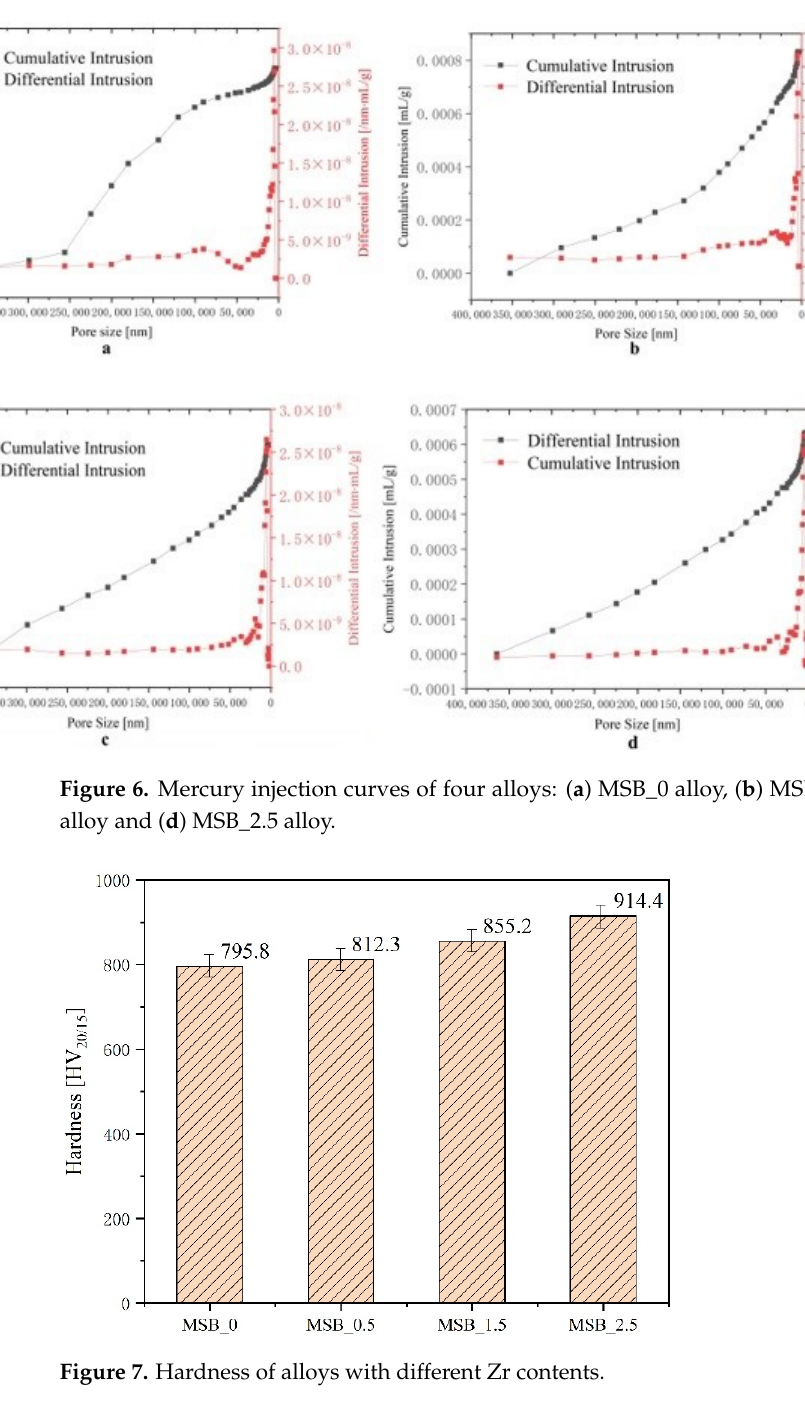
Figure 7. Hardness of alloys with different Zr contents: